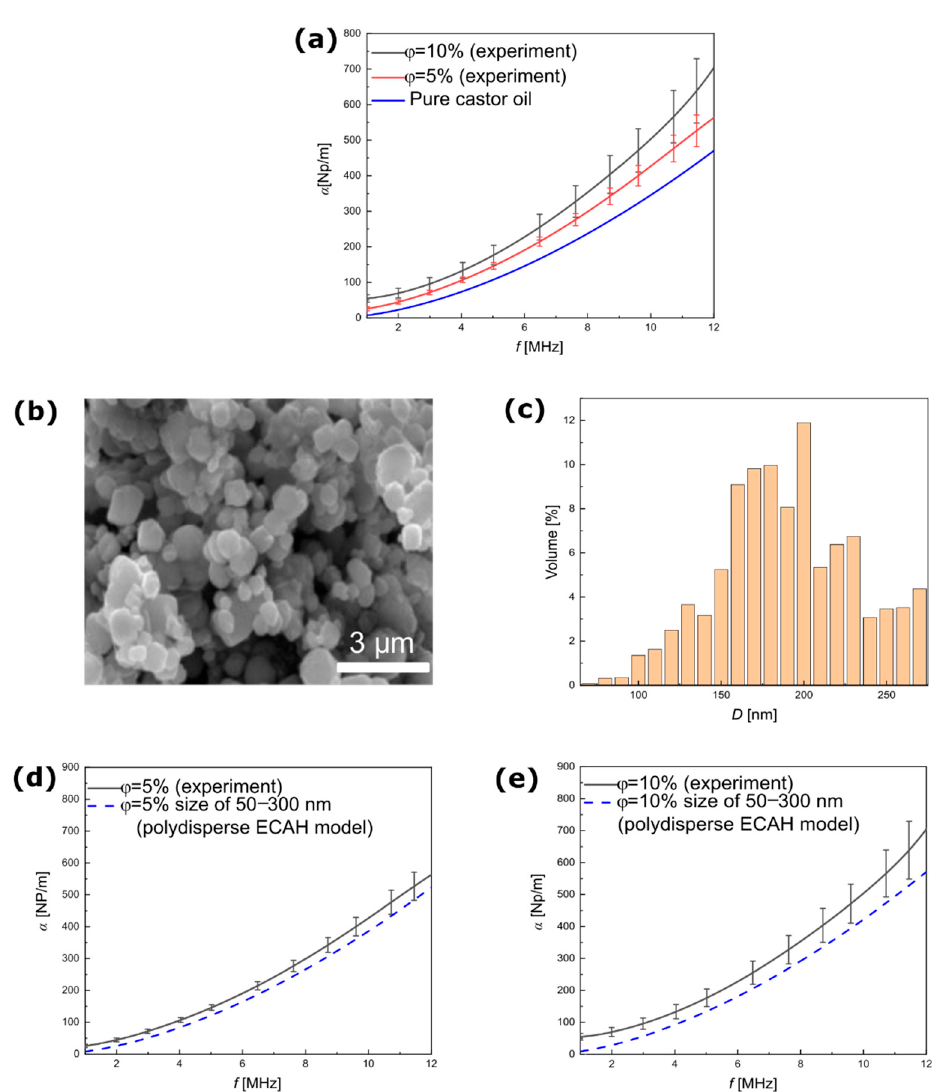
Figure 5. Experimental and theoretical results of ultrasound attenuation of magnetite NPs dispersed in castor oil. ( a ) Ultrasound attenuation coefficient versus the frequency measured for the mass concentrations of particles of 5% and 10%. ( b ) SEM image of the magnetite NPs used. ( c ) PSD for the magnetite NPs calculated from the SEM image. ( d ) Comparison of the ultrasound attenuation coefficient versus the frequency measured and calculated based on the ECAH model for the mass concentration of particles at 5% and ( e ) 10%.